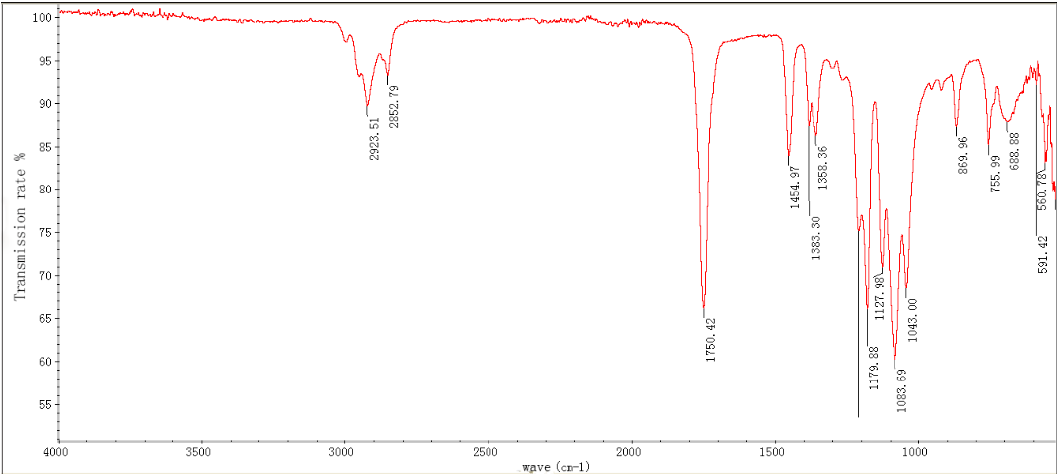
Figure 4. Infrared spectrum of PLA multifilament.